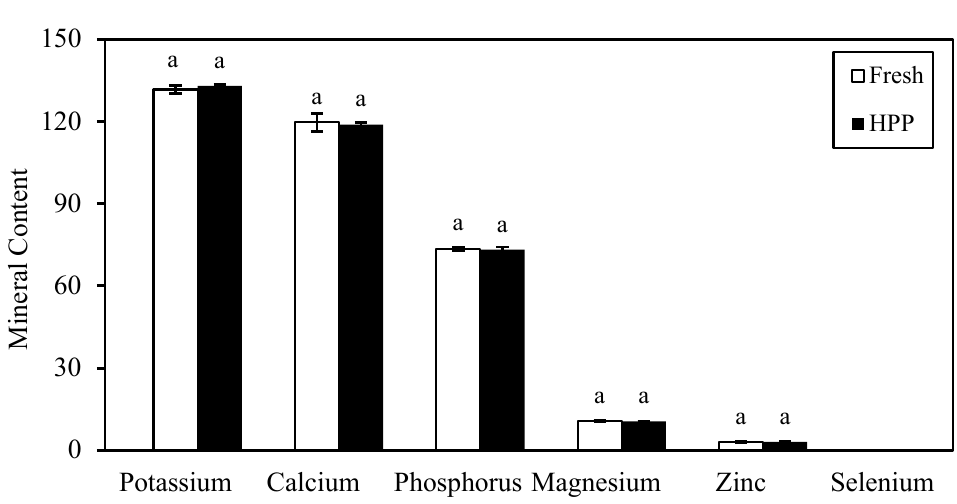
Figure 4. Changes in mineral content of fresh milk after HPP treatment. Potassium, Calcium, Phos- phorus, and Magnesium in unit mg/100mL; Zinc and Selenium in unit mg/kg. Alphabet “a” repre- sent no significant difference between bar at p > 0.05.